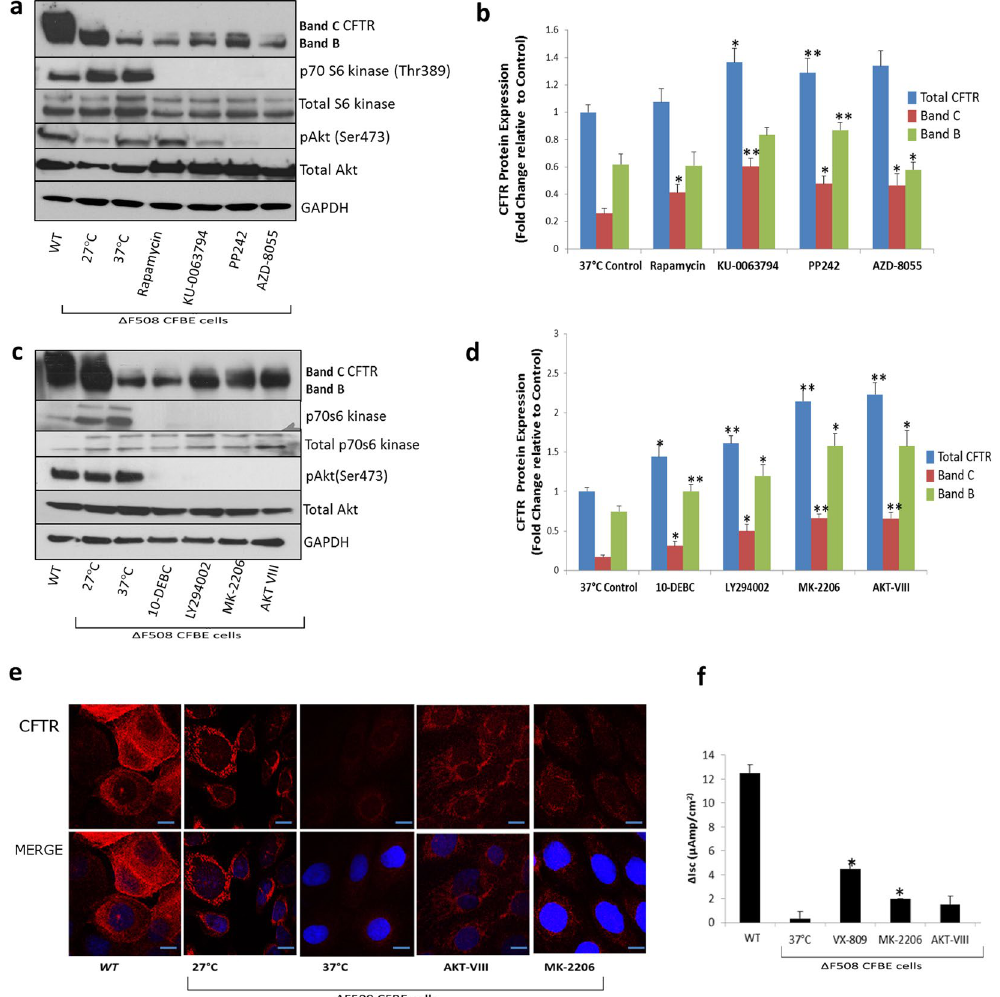
Figure 3. Targeting the PI3K/Akt/mTOR complex improves CFTR stability and function. ( a) Δ F508 CFBE41o- cells (37 °C) were treated with Rapamycin, AZD-8055, PP-242, KU-0063794 (Set 1 inhibitors) and immunoblotting was performed for CFTR, pAkt Ser 473, p70 S6 kinase Thr389, Akt and p70 S6 kinase and GAPDH. WT HBE41o- cells and Δ F508 CFBE41o- cells incubated at 27 °C were included as positive controls and Δ F508 CFBE41o- cells incubated at 37 °C were included as a negative control. ( b ) A quantitative graph of CFTR (Total, Band B, Band C) from CFBE41o- cell lysates treated with Set 1 inhibitors. The results shown are representative of three independent experiments; the histograms represent the average and the error bars represent the standard deviation of the means. Statistical significance was examined using a two-tailed paired T-test analysis. Asterisk * represents p < 0.05, ** represents p < 0.01. ( c) Δ F508 CFBE41o cells (37 °C) were treated with LY-294002, 10-DEBC, MK-2206 and AKT-VIII and immunoblotting was performed for CFTR, pAKT Ser473, p70 S6 kinase Thr389, Akt and p70 S6 kinase and GAPDH. WT HBE41o- cells and Δ F508 CFBE41o- cells incubated at 27 °C were included as positive controls and Δ F508 CFBE41o- incubated at 37 °C were used as a negative control. ( d) A quantitative graph of CFTR (Total, Band B, Band C) from Δ F508 CFBE41o lysates treated with Set 2 inhibitors. The results shown are representative of three independent experiments; the histograms represent the average and the error bars represent the standard deviation of the means. Statistical significance was examined using a two-tailed paired T-test analysis. Asterisk * represents p < 0.05, ** represents p < 0.01. ( e) Fluorescent detection was used to visualise CFTR (red- 549 nm) in Δ F508 CFBE41o- cells treated with MK-2206, AKT-VIII along with a negative control Δ F508 37 °C, positive controls Δ F508 27 °C and WT HBE41o- cells. Nuclei were stained with DAPI (blue- 358 nm). Scale bar is 10 µ m. ( f ) Bar graph representing the change in Isc ( Δ I sc ) after forskolin (10 µ M) and genistein (50 µ M) addition relative to baseline readings in CFBE41o- cells treated with MK-2206, AKT-VIII, a negative control Δ F508 37 °C, positive controls VX-809 treatment and WT HBE41o- cells. Statistical significance was tested by a two-tailed paired T-test analysis. Asterisk * represents p <